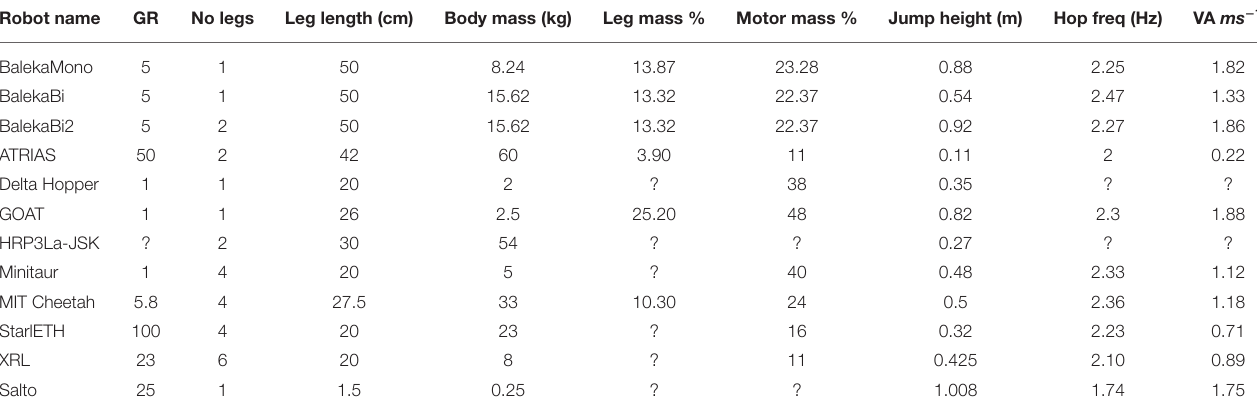
TABLE 2 | Table comparing the different metrics (Park et al., 2014; Hubicki et al., 2016; Kalouche, 2016) of the robot developed in this work compared to other existing